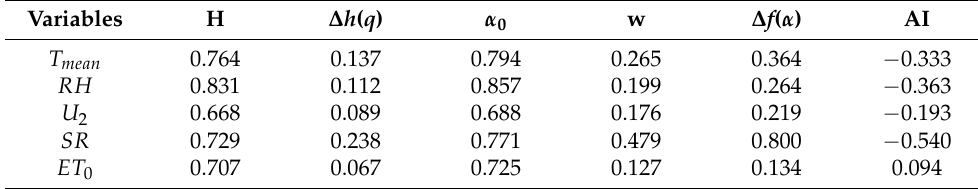
Figure 3. Multifractal plots of agro-meteorogical variables. ( a ) Generalized Hurst exponents. ( b ) Multifractal spectra. Table 2. Multifractal parameters of the agro-meteorogical variables.